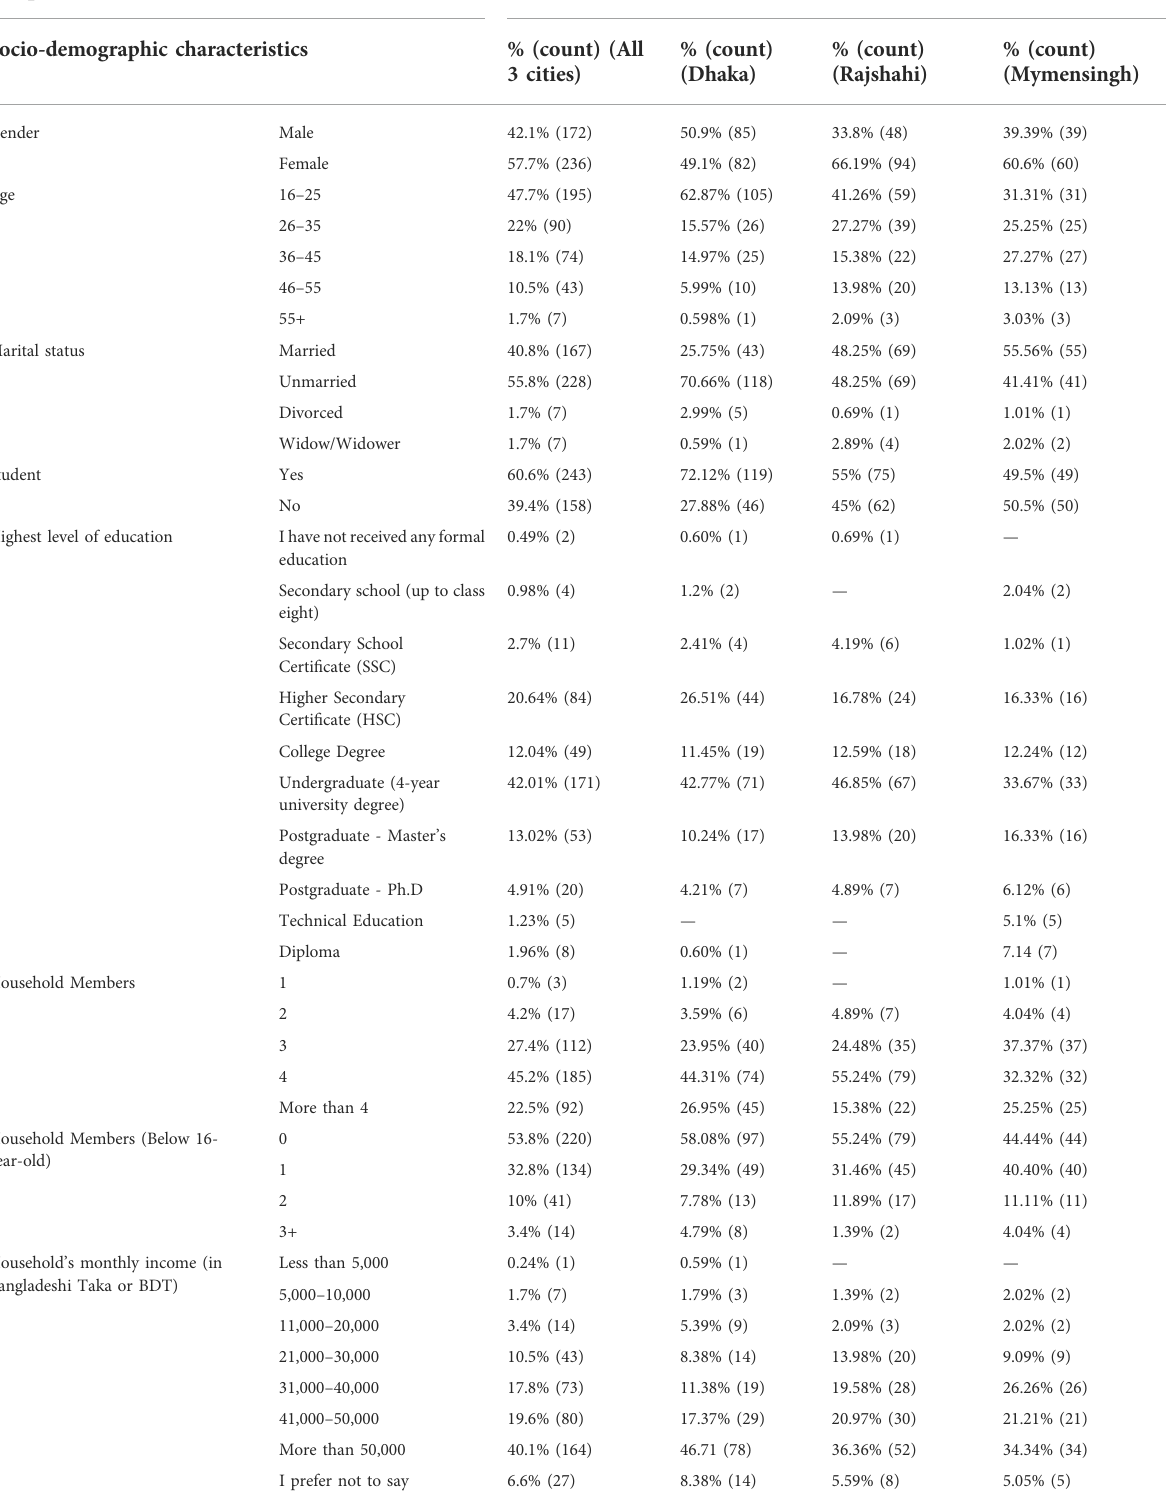
TABLE 1 Distribution of the socio-economic variables of the